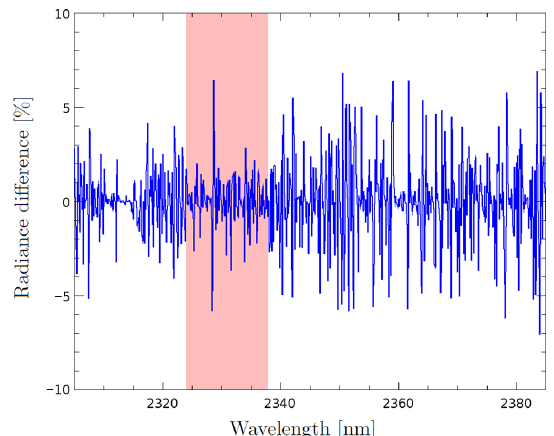
Figure B3. Spectral features due to the inhomogeneous slit illumi- nation as a percentage of the continuum value. Simulations are per- formed for a transition in the flight direction from a cloudy scene to a clear sky scene at + 1.8km away from barycenter x 0 . Here, the cloud is located between 2 and 3km with a total optical depth of 10. The CO fitting window is indicated by the pink shadowed